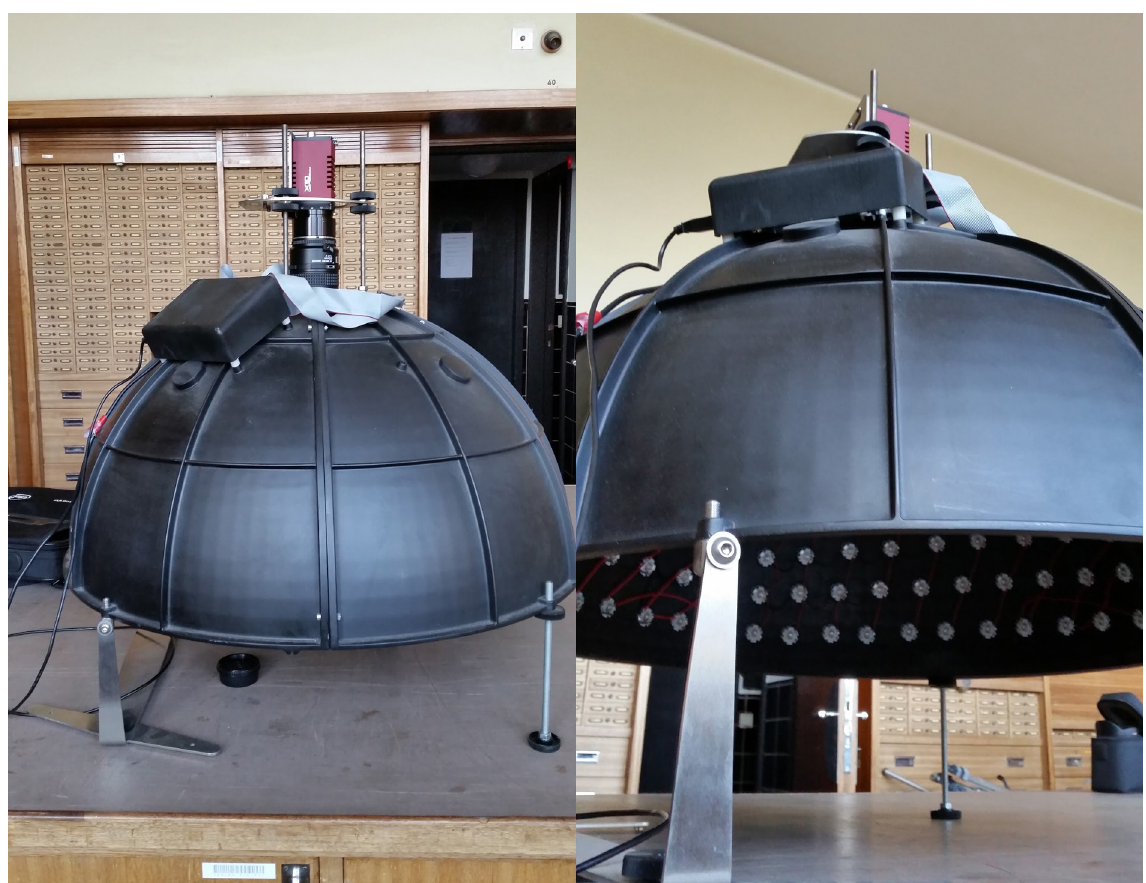
Fig. 2.29. The PLD setup. Left: general view of the dome with the machine vision camera mounted on top. Right: view of some of the 260 LEDs of the